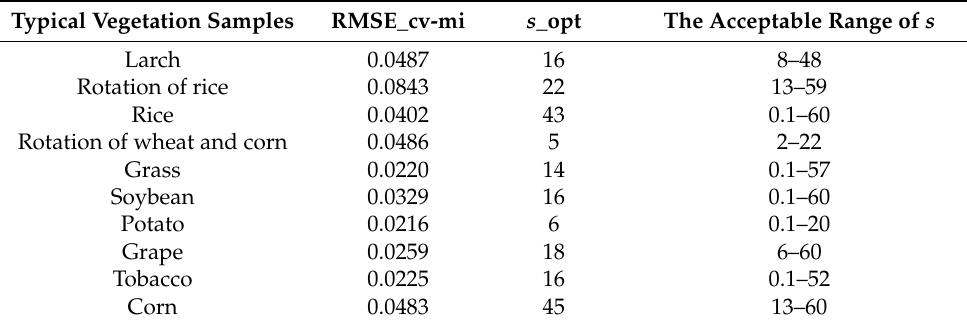
Table 4. The acceptable range of s of typical vegetation samples when N = 24. Typical Vegetation